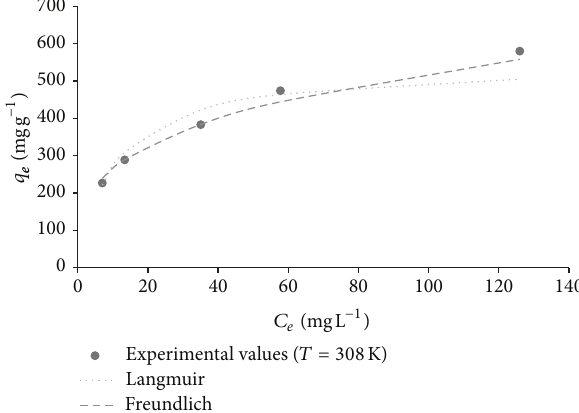
Figure 10: The Langmuir and Freundlich isotherms for the adsorp- tion of MB onto CHAC Z (adsorbent dose: 0.3 gL −1 ; pH: 4; tempera- ture: 308 K).